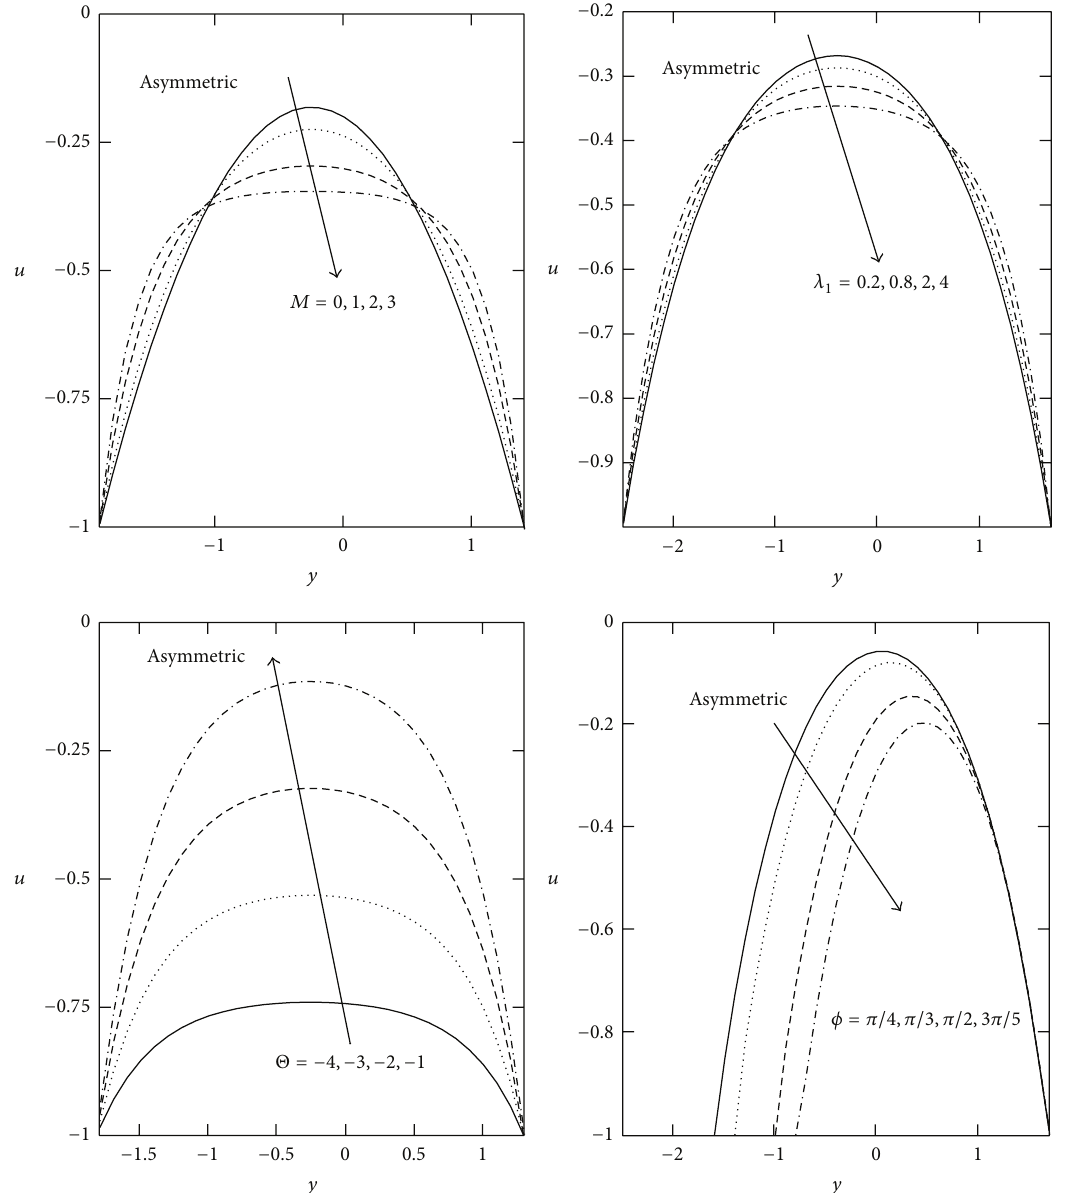
Figure 6: Variation of 𝑢 with influence of 𝑀 , 𝜆 1 , Θ , and 𝜙 with respect to 𝑦